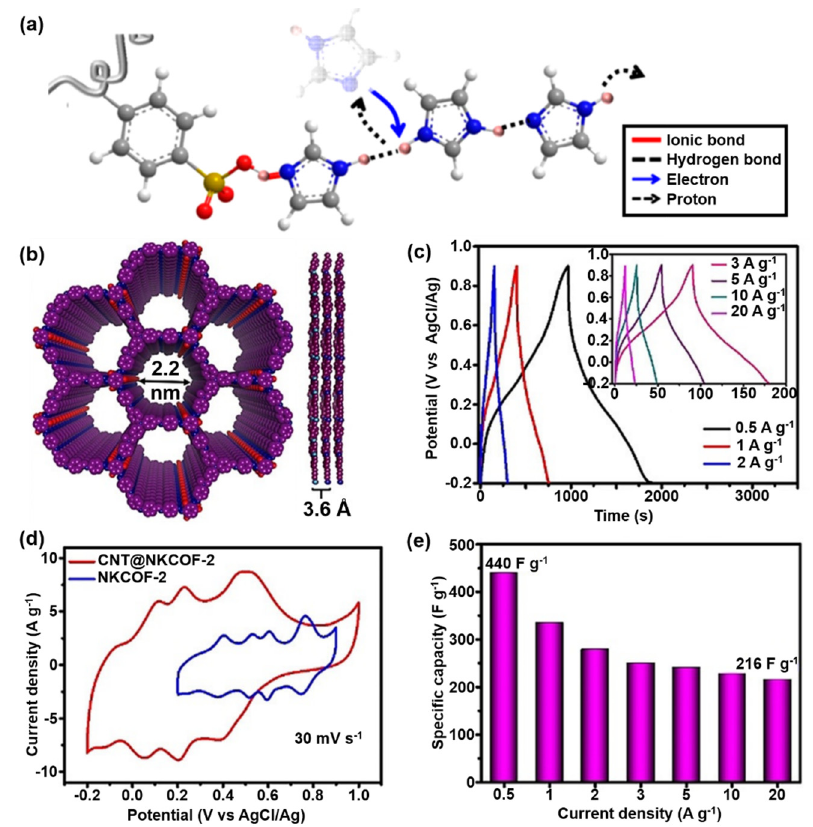
Figure 2. Grotthuss transfer strategy has positive effects on electrochemical performance. ( a ) Schematic illustrations of the Grotthuss transport mechanisms [44]. Copyright 2014, American Chemical Society. ( b ) Simulated structure of NKCOF–8. ( c ) Galvanostatic charge-discharge curves of CNT/NKCOF–2 at different current densities. ( d ) CV curves of NKCOF–2 and CNT/NKCOF–2 at a scan rate of 30 mV s − 1 . ( e ) Specific capacities of CNT/NKCOF–2 at different current densities [47]. Copyright 2021, Wiley-VCH.